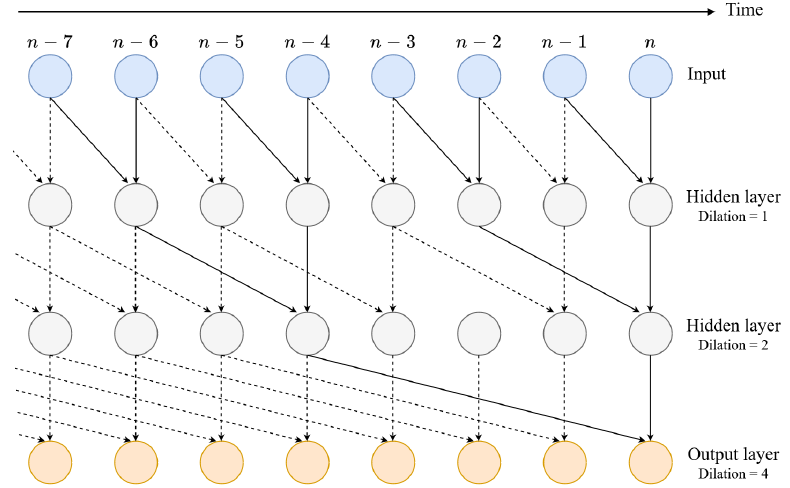
Figure 1. The general WaveNet architecture comprising various layers of dilated convolutions, illustrated here with a receptive field of size 8. Figure adapted from [26].